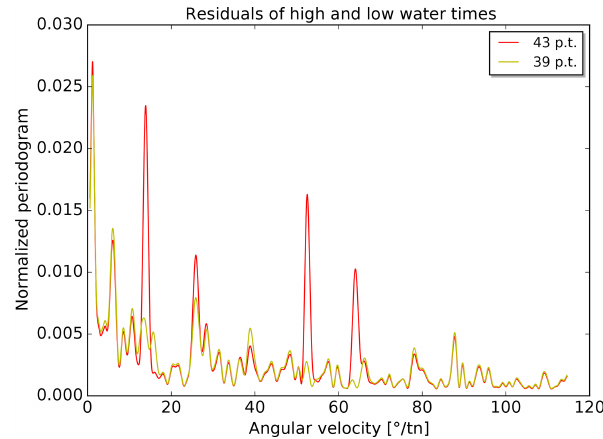
Figure 10. Mean periodogram of residual high- and low-water times for all tide gauges used in the verification. The different colours indicate predictions based on the different sets of partial tides (red: predictions with 43 partial tides; yellow: predictions with 39 partial tides)